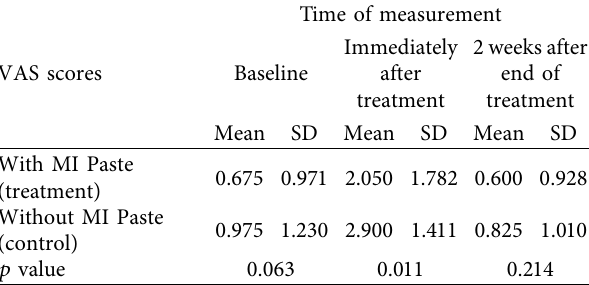
Table 1: Mean (SD) thermal sensitivity scores at each time point for treatment and control